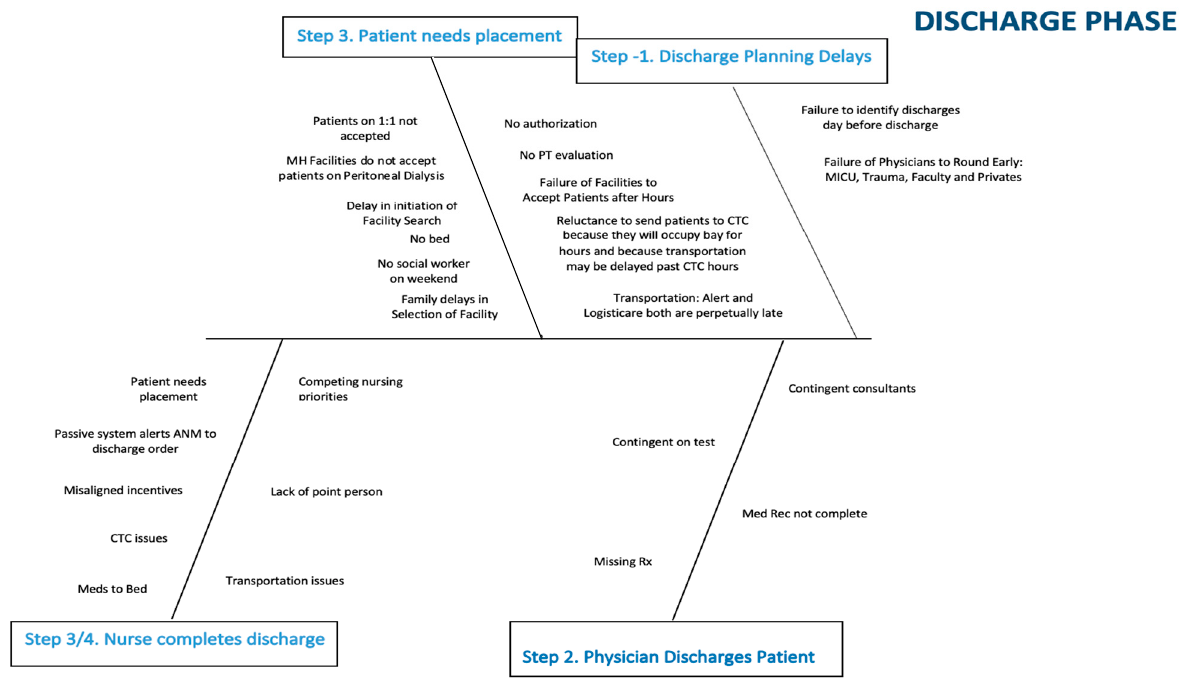
Figure 2. Fishbone diagram representing discharge planning and placement delays.